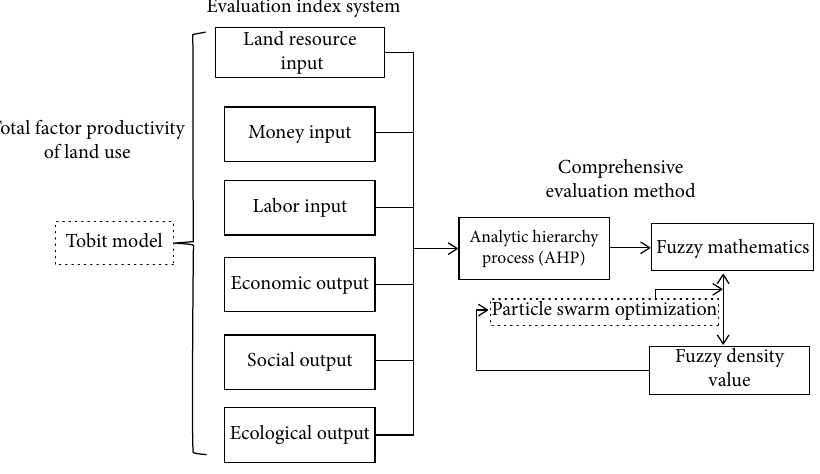
Figure 1: The technology roadmap in this